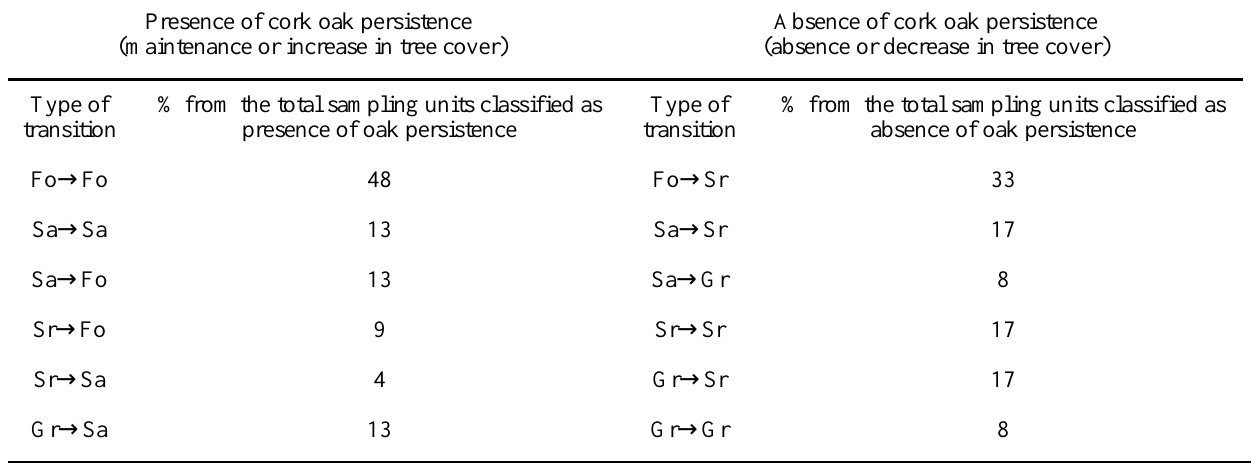
Table 2. Types of vegetation transitions (1958-2002) grouped into presence of cork oak ( Quercus suber L.) persistence or absence of cork oak persistence (Fo: forest; Sa: savanna; Sr: shrubland; Gr: grassland) Presence of cork oak persistence (maintenance or increase in tree cover) Type of transition